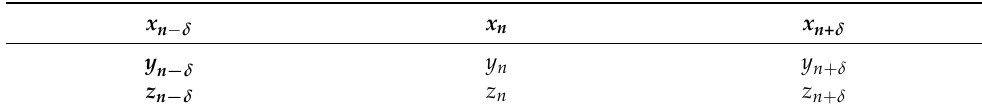
Table 1. The nine different elements of the time series x , y , and z with current, time-backward, and time-forward indexes.